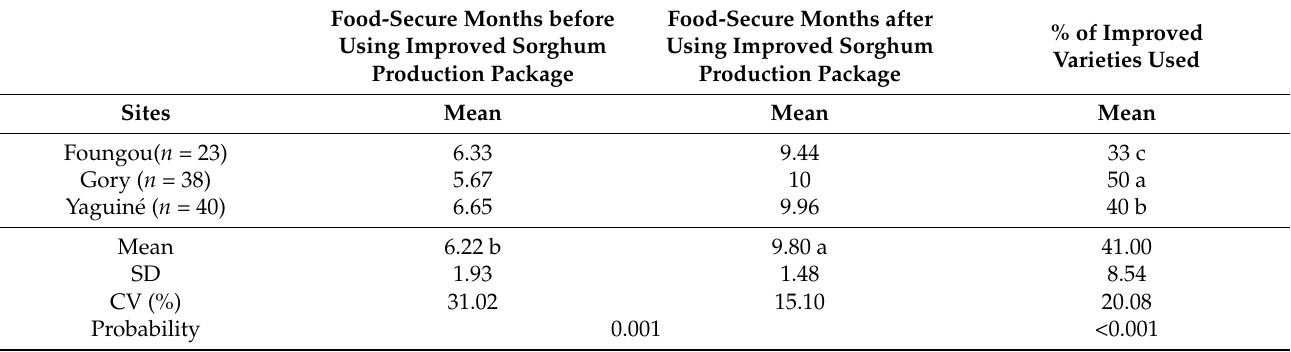
Table 11. Impact of new flood recession sorghum varieties on household food security in Yaguine, Gory, and Foungou, from the 2013/2014 to the 2020/2021 cropping season. Food-Secure Months after Food-Secure Months before % of Improved Using Improved Sorghum Using Improved Sorghum Varieties Used Production Package Production Package Sites Mean Mean Mean Foungou( n = 23) 6.33 9.44 33